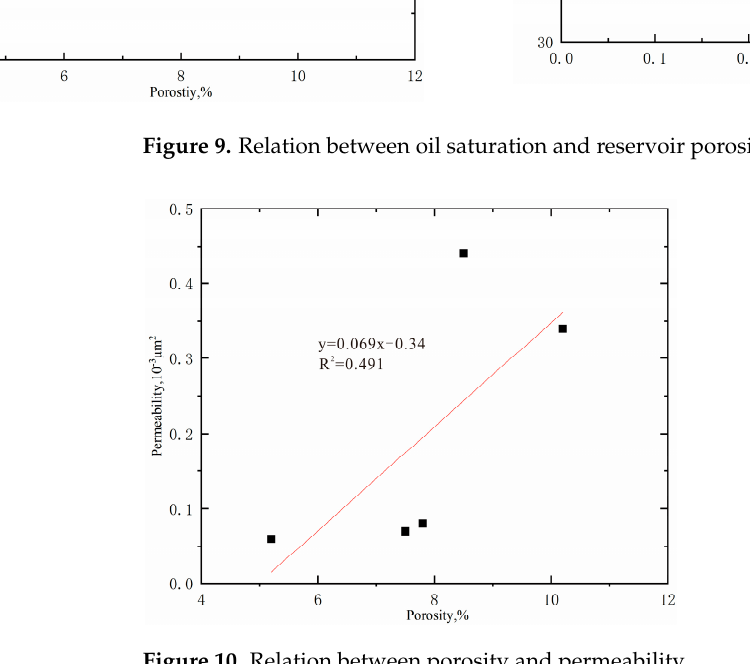
Figure 10. Relation between porosity and